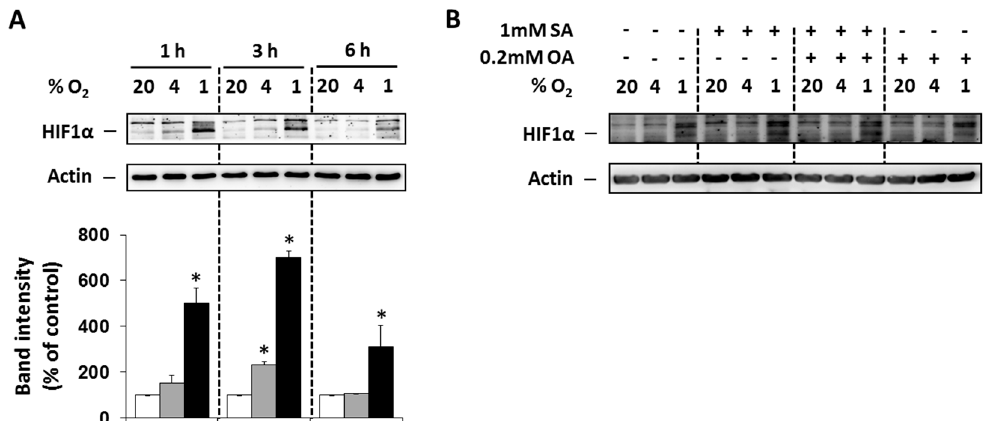
Figure 1. ( A ) E ff ect of hypoxia (see “Materials and Methods”) on the level of HIF1 α within 6 h of the treatment in NES2Y cells. ( B ) E ff ect of hypoxia applied with 1 mM stearic acid (SA), 1 mM SA plus 0.2 mM oleic acid (OA), and 0.2 mM OA (see “Materials and Methods”) on the level of HIF1 α 3 h after the treatment in NES2Y cells. Level of HIF1 α was determined using western blot analysis employing relevant antibody (see “Materials and Methods”). The actin level was used to confirm equal protein loading. The data shown were obtained in one representative experiment from at least three independent experiments. Densitometric analysis concerning data ( A ) is also shown. * p < 0.05 when comparing the e ff ect of a particular hypoxia with external normoxia (20% O 2 , control).